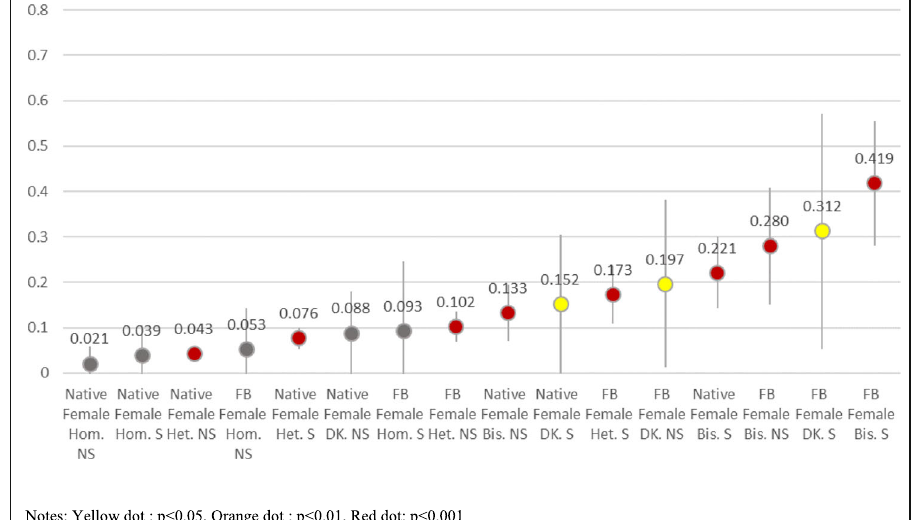
Fig. 1 Probability of previous experience of SVV for female students according to the place of birth, sexual orientation, and previous sexual experience with someone of the same sex. Adjusted predictions, other variables at the means. Notes: Yellow dot: p < 0.05, Orange dot: p < 0.01, Red dot: p < 0.001. Sexual orientation: Hom = homosexual, Bis = bisexual, Het = heterosexual, DK = does not answer, previous same- sex sexual experience: NS = no, S = yes, FB =